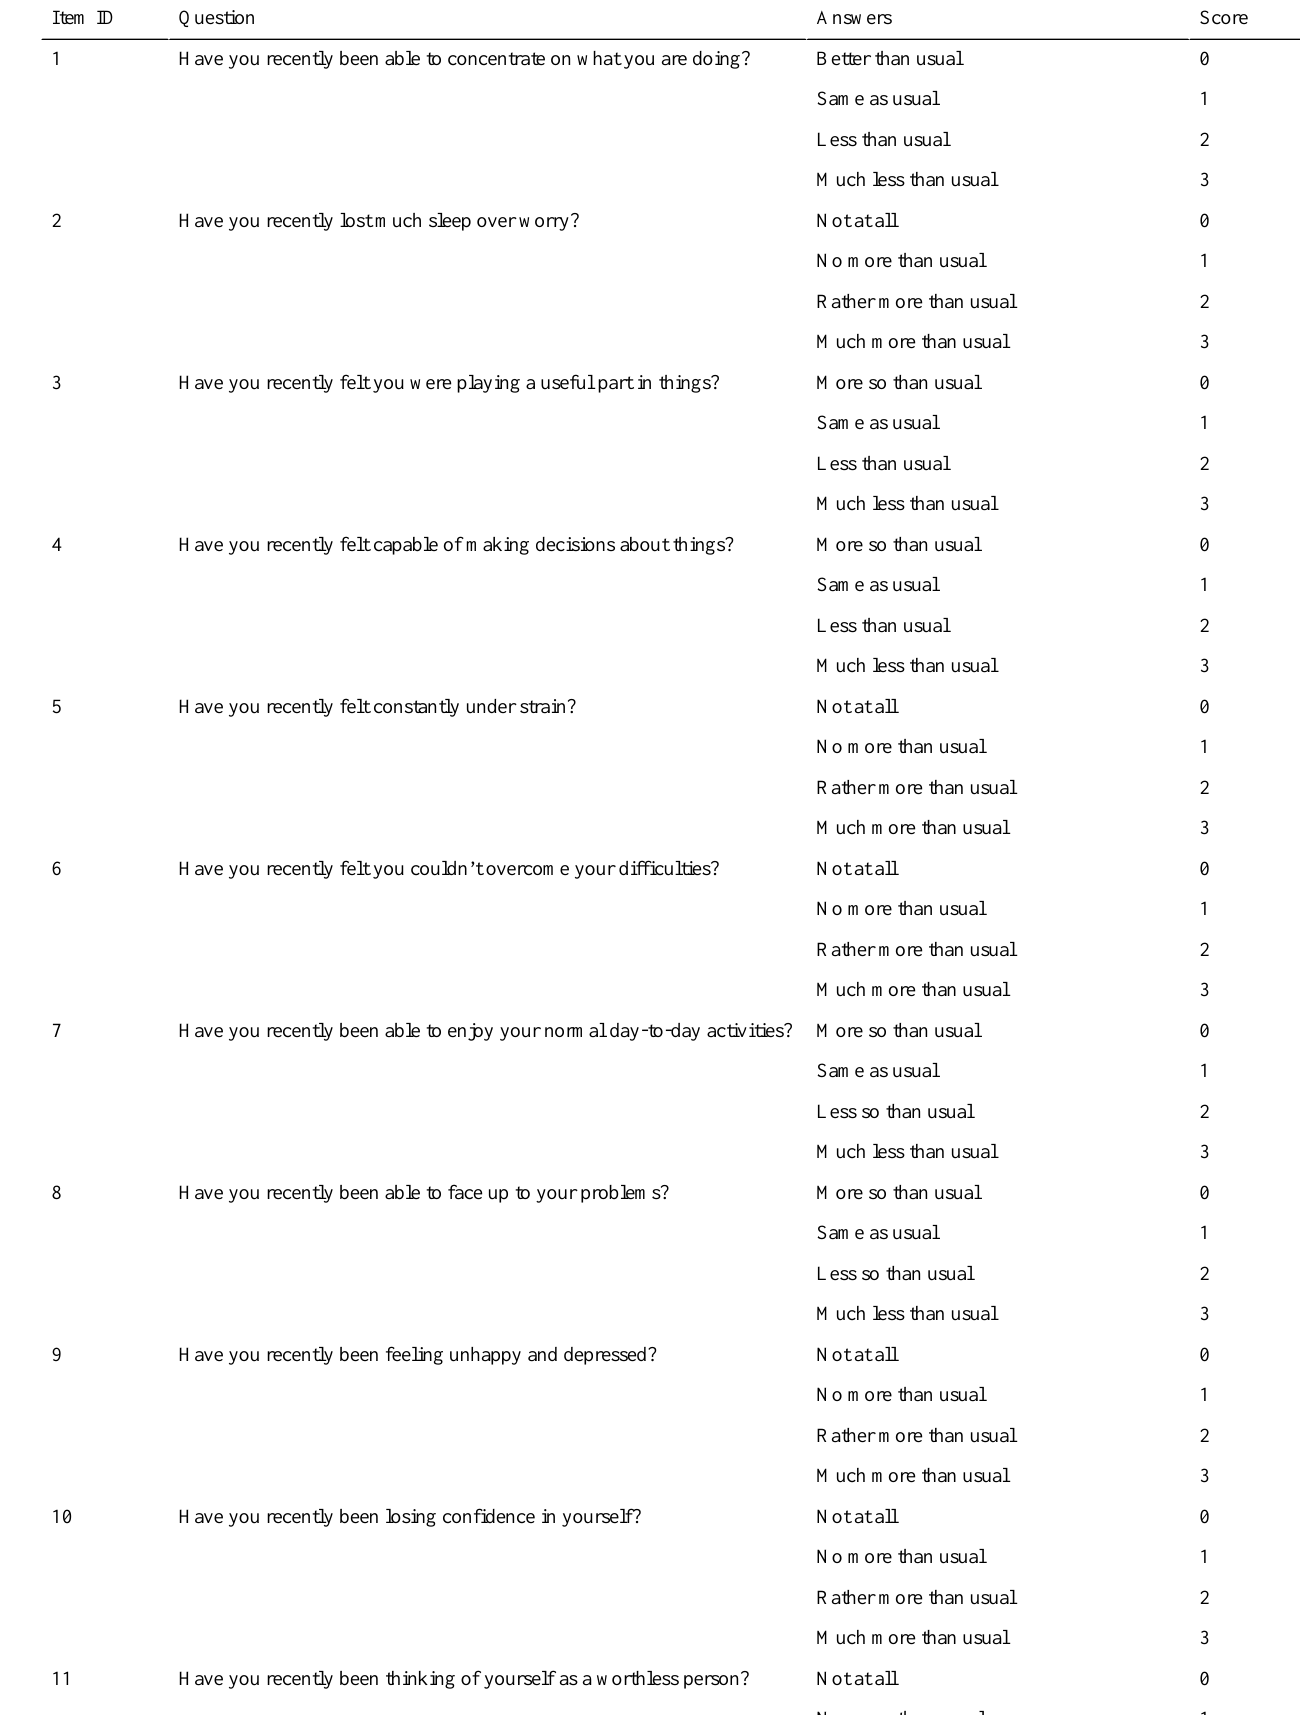
Table 1. Questions, answers, and scores of the 12-item General Health Questionnaire. ScoreAnswersQuestionItem